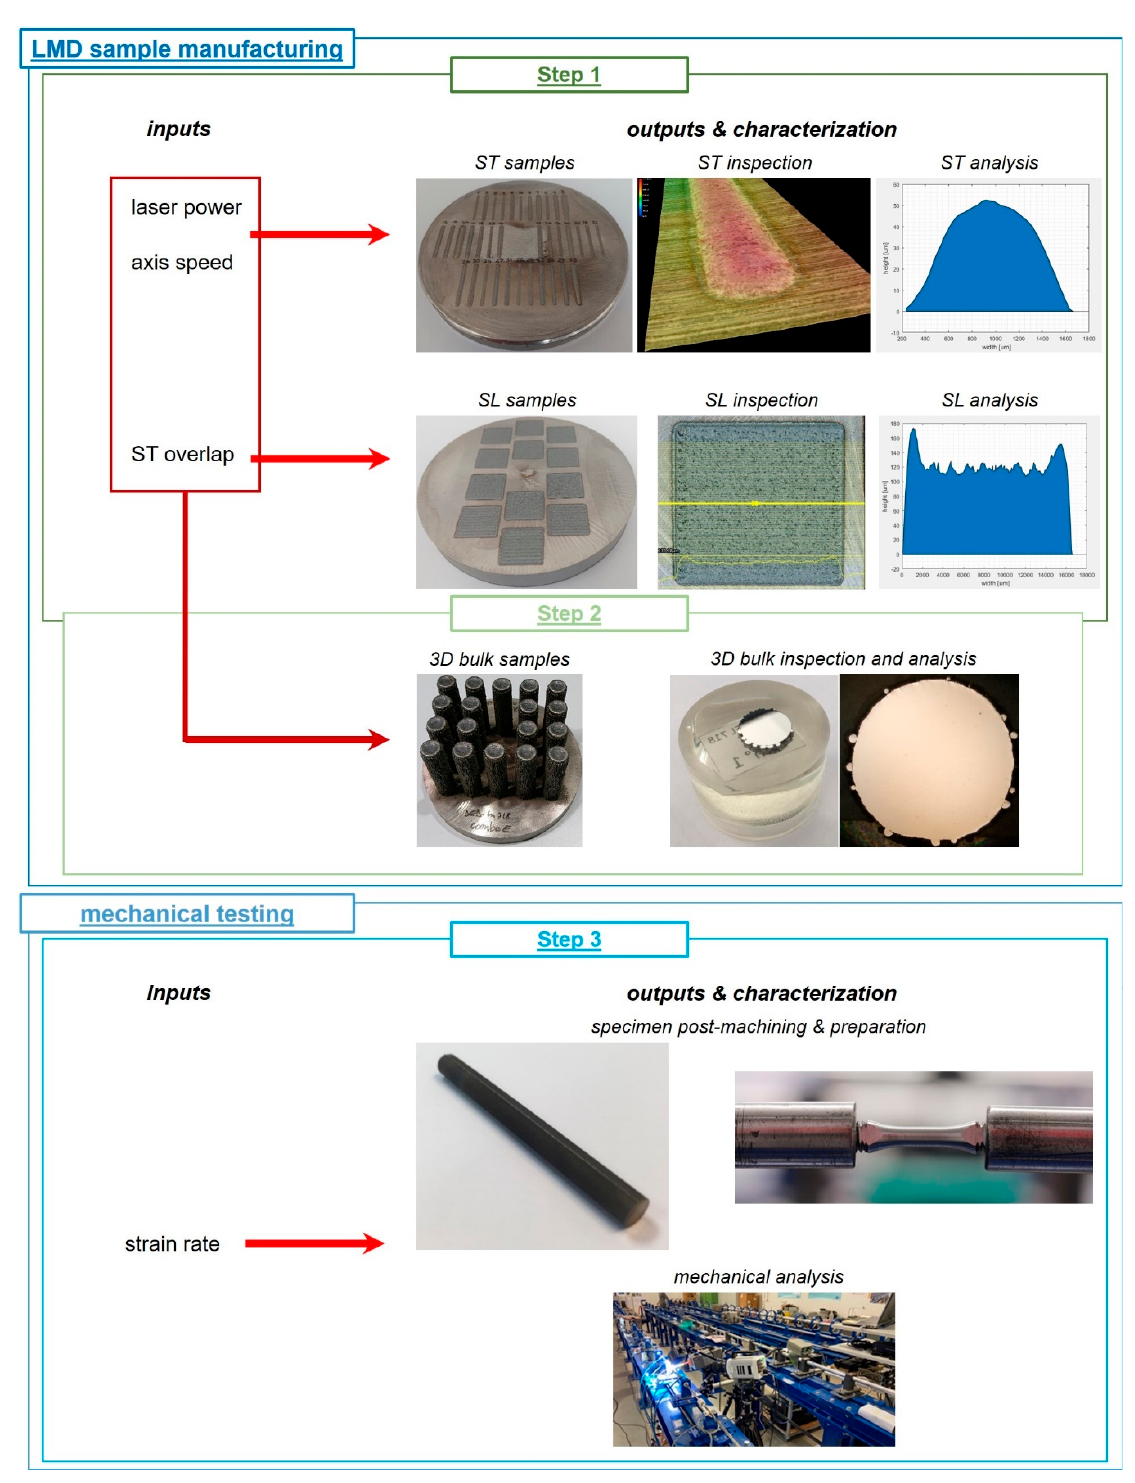
Figure 3. Structure of the designed experimental campaign.